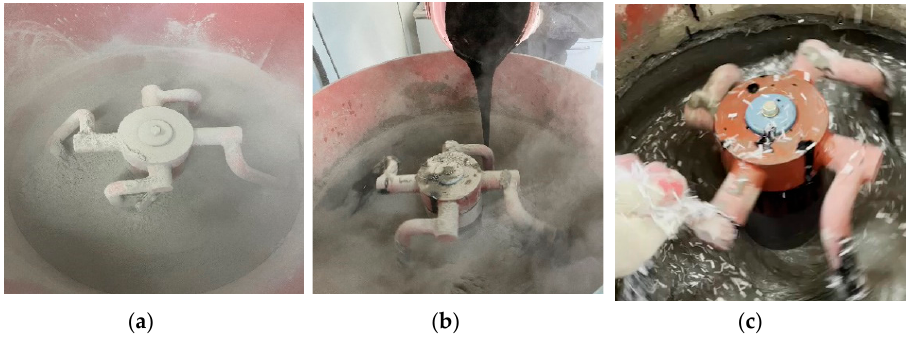
Figure 4. Mix procedure of PVA cementitious composites with CNTs. ( a ) Dry mix, ( b ) Addition of water and CNTs, ( c ) Addition of PVA fibers.